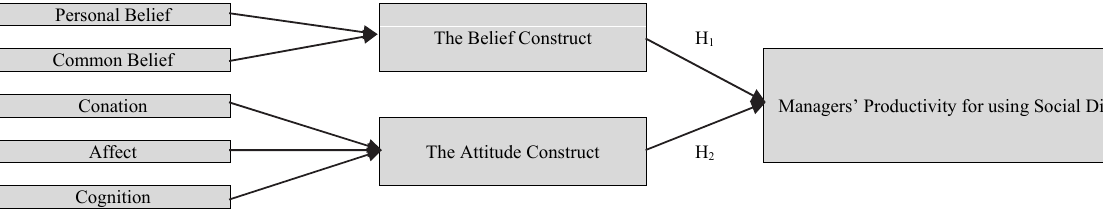
Fig. 1. Conceptual framework in pictorial